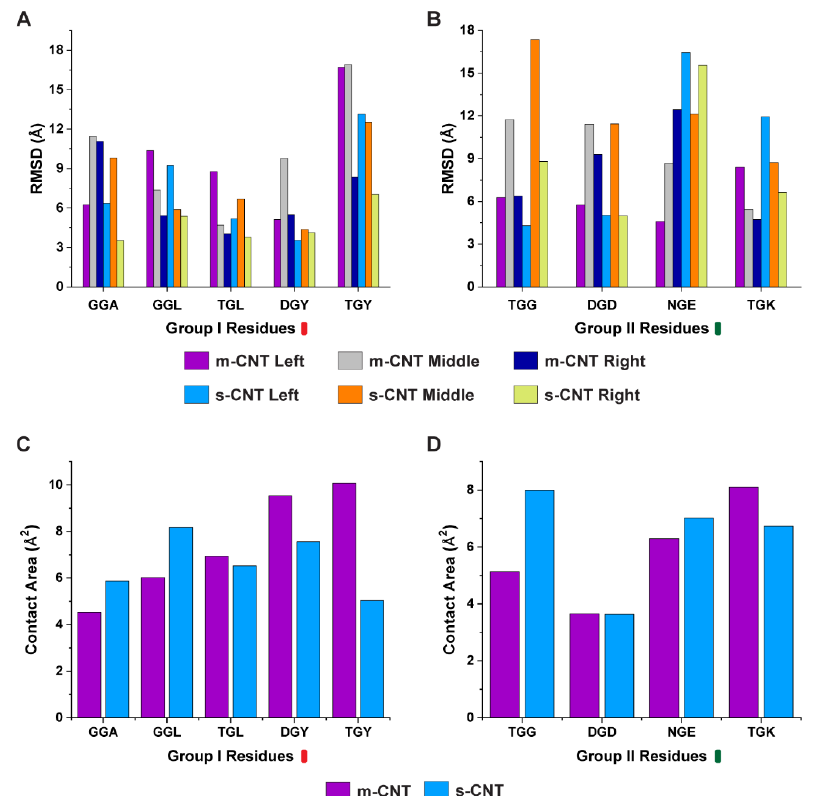
Figure 4. Individual average RMSD analysis for the left (L), middle (M), and right (R) residues of the tripeptides with respect to the metallic and semiconducting CNTs for ( A ) Group I and ( B ) Group II set of tripeptides. ( C , D ) show the contact area of the two groups of tripeptide combinations with the metallic and semiconducting CNT.